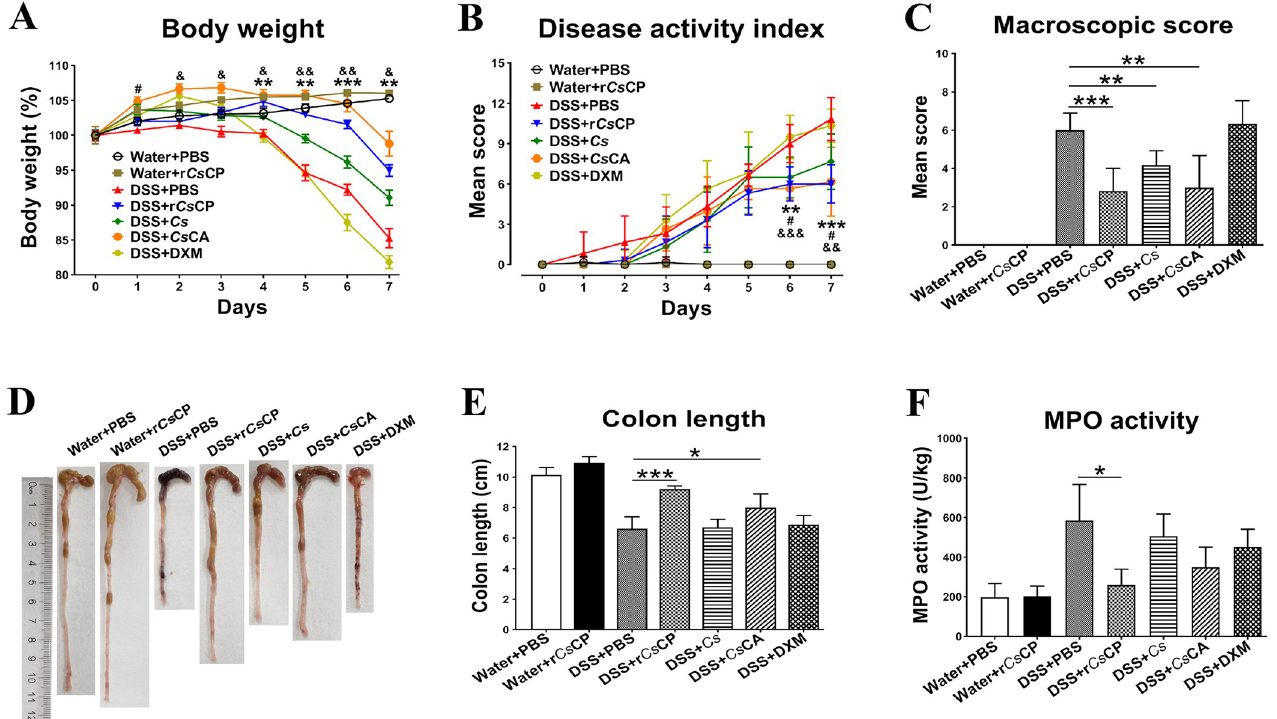
Fig 2. Attenuated clinical activity of DSS-induced colitis in mice by different treatments. (A) The body weight loss of mice in each group for 8 consecutive days (n = 6). (B) The change of disease activity index (DAI) of each group during the trial period (n = 6). (C) The macroscopic score of colons in each group (n = 6). (D) Representative colons from each group. (E) Average length of colon in each group (n = 6). (F) Colonic MPO activity (n = 4). Data are displayed as mean ± SEM. (A) and (B): �� P < 0.01, ��� P < 0.001 (DSS+PBS group versus DSS+r Cs CP group); & P < 0.05, && P < 0.01, &&& P < 0.001 (DSS+PBS group versus DSS+ Cs CA group); # P < 0.05 (DSS+PBS group versus DSS+ Cs group). (C), (E) and (F): � P < 0.05, �� P < 0.01, ��� P < 0.001 (compared with the DSS +PBS